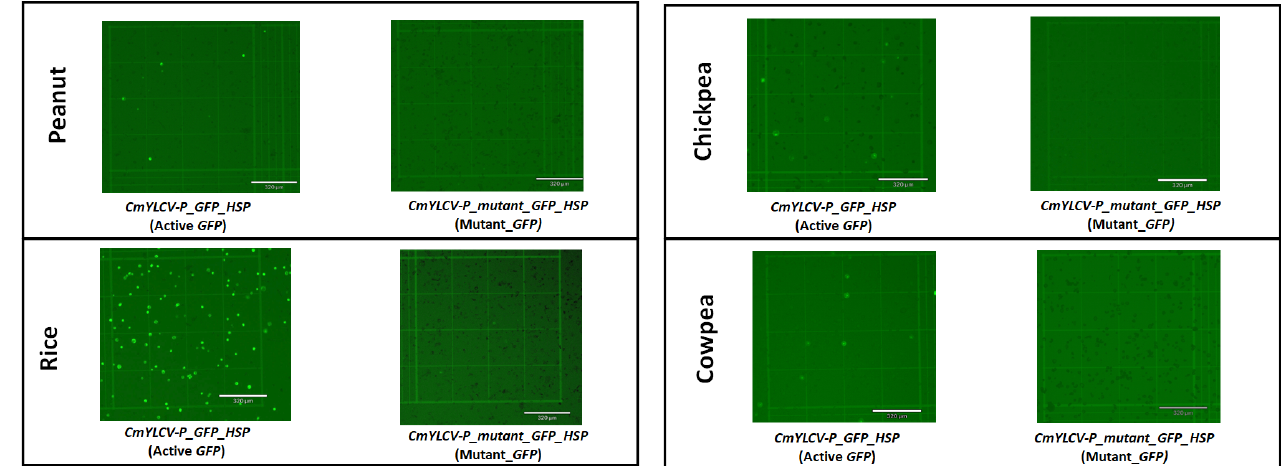
Figure 2. Testing of active GFP and mutant GFP cloning vectors in peanut, rice, chickpea, and cowpea protoplasts via PEG transformation. Micrographs of protoplasts expressing active GFP and mutant GFP under the fluorescent field are shown. The scale bar length for all the pictures was 320 µm. Micrographs under the bright field are shown in Supplementary Figure S1.